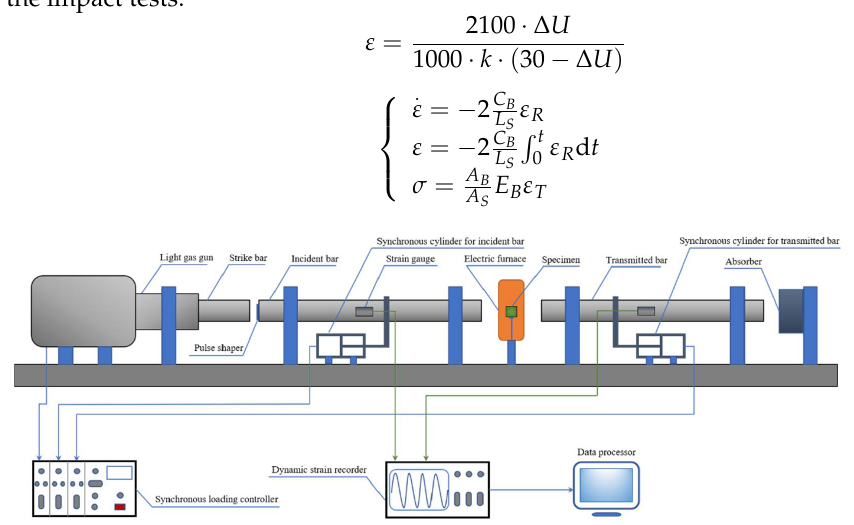
Figure 2. Diagram of the SHPB system used in this work.